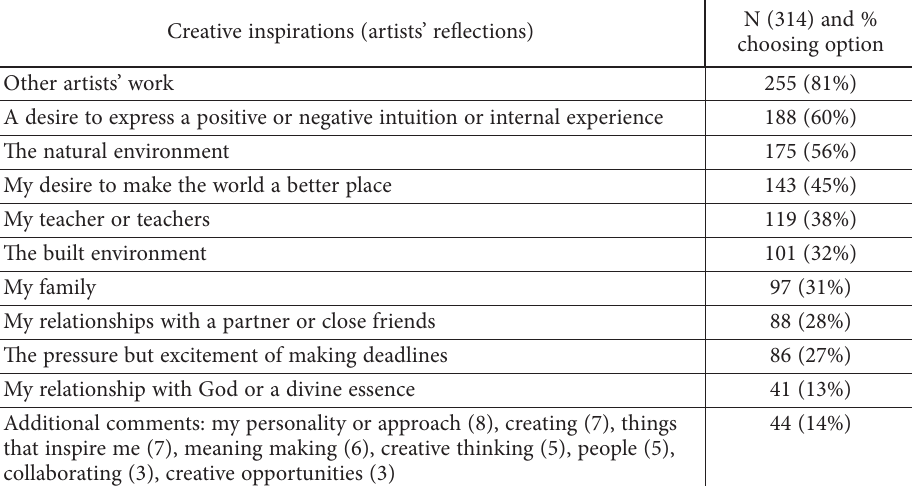
Table 4. Inspirations of participants’ ongoing creativity (source: created by